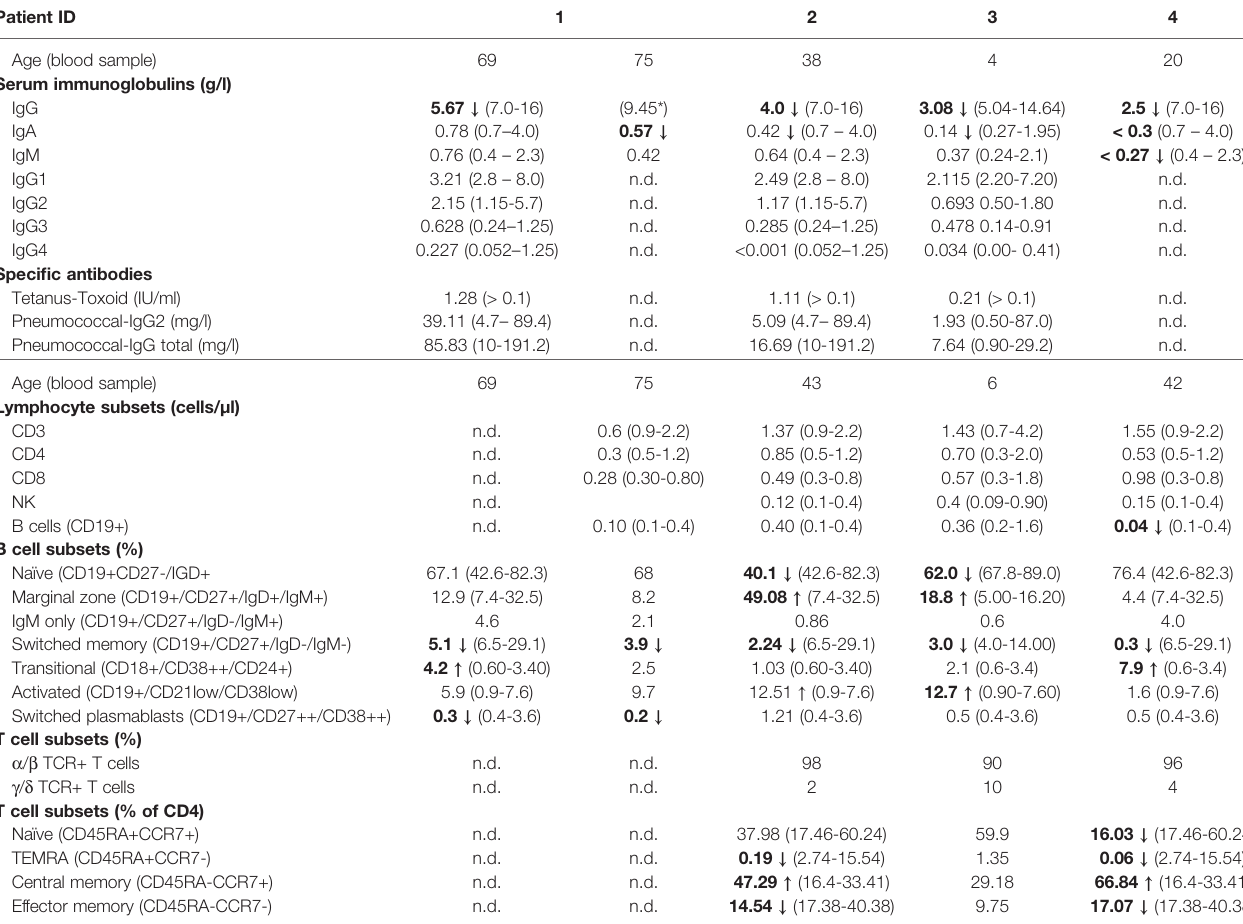
TABLE 1 | Immunoglobulin levels prior to IgG substitution and lymphocyte subsets. Patient